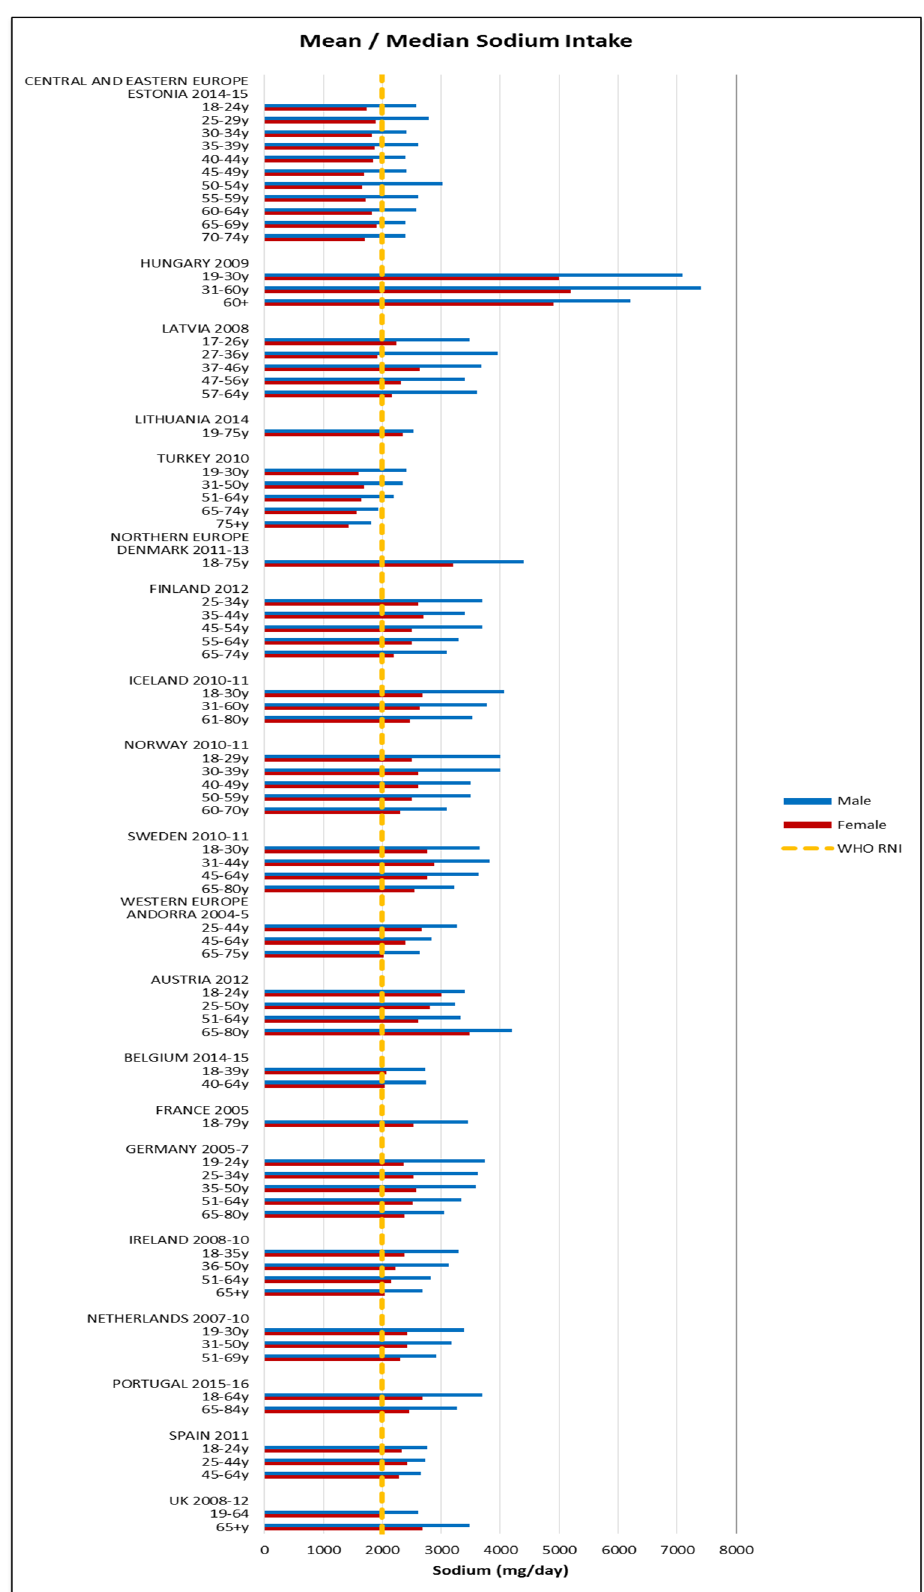
Figure 13. Mean/median* adult sodium intake (mg/day) (excluding supplements). * Figures for Spain are based on median rather than mean values.